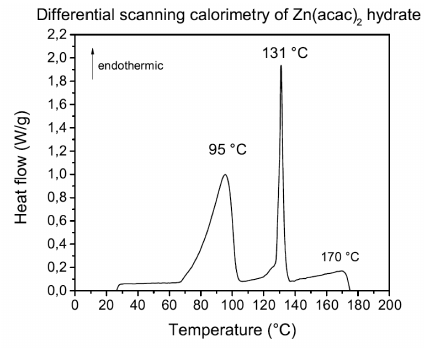
Figure 5. Zinc acetylacetonate DSC in nitrogen atmosphere at atmospheric pressure. Heating rate: 5 ◦